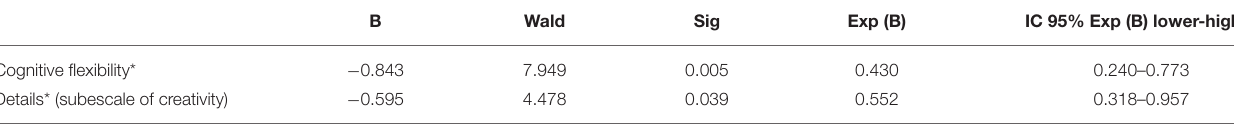
TABLE 3 | Model of logistic regression for the attitude toward mathematics. B Wald Sig Exp (B) IC 95% Exp (B) lower-higher Cognitive flexibility* − 0.843 7.949 Details* (subescale of creativity) −